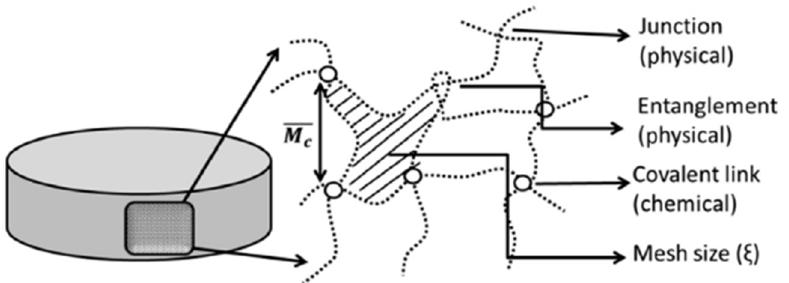
Figure 1. Microstructural parameters of hydrogels. (Reprinted with permission from [5]. Copyright 2020, Elsevier).